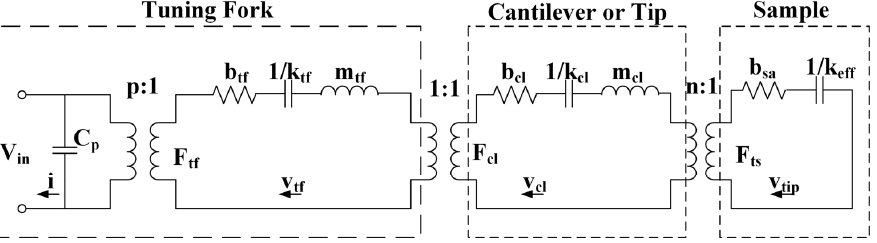
Figure 3. The electromechanical coupling model of normal probes.